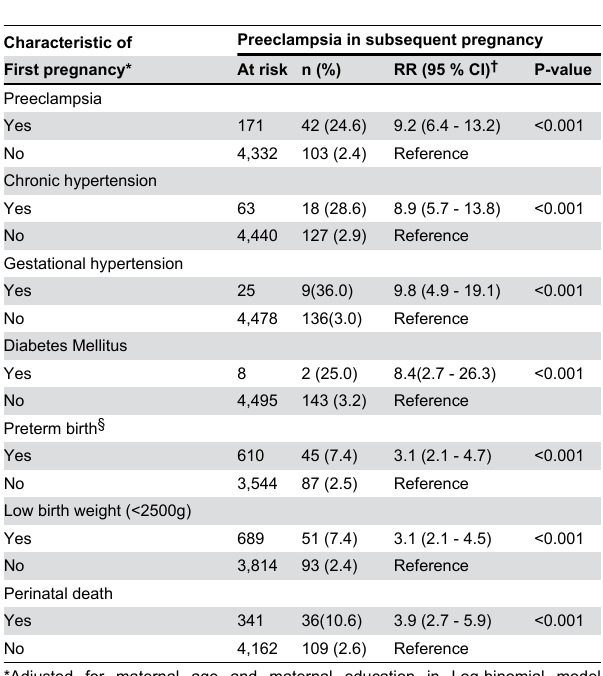
*Adjusted for maternal age and maternal education in Log-binomial model accounting for correlation between successive deliveries of the same mother. † RR=Adjusted Relative Risk, CI= Confidence Interval § Does not add to total because 349 (7.8%) missed gestational age doi: